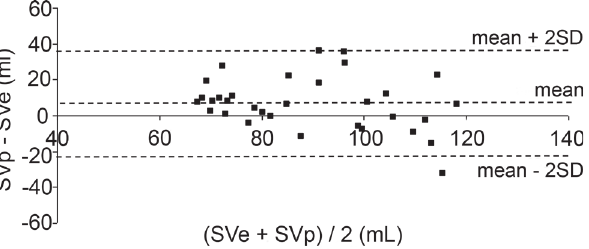
Fig 4. Bland-Altman plots for determination of agreement between SVe and SVp computed with the Liljestrand algorithm. —— : limits of agreement (maximum, minimum,